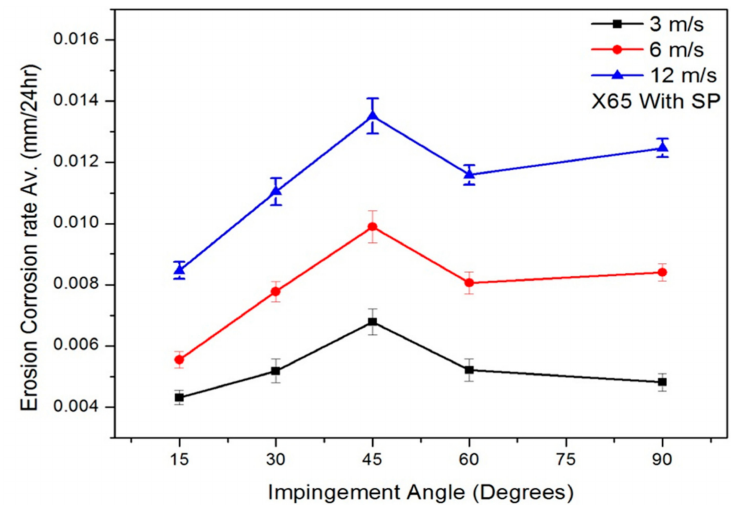
Figure 5. Effect of impingement velocity and angle on erosion corrosion rate (with solid particles) of API 5L-X65